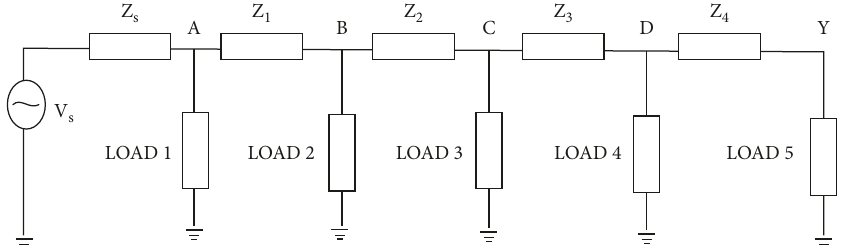
Figure 1: Representation of the linear and nonlinear loads in a framework of radial